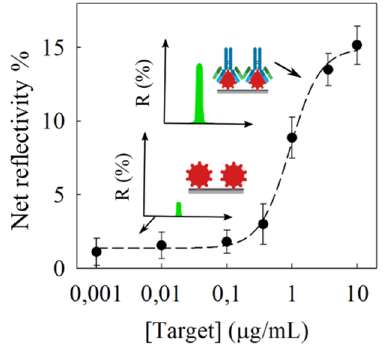
Fig. 2. Experimental immunoassay using